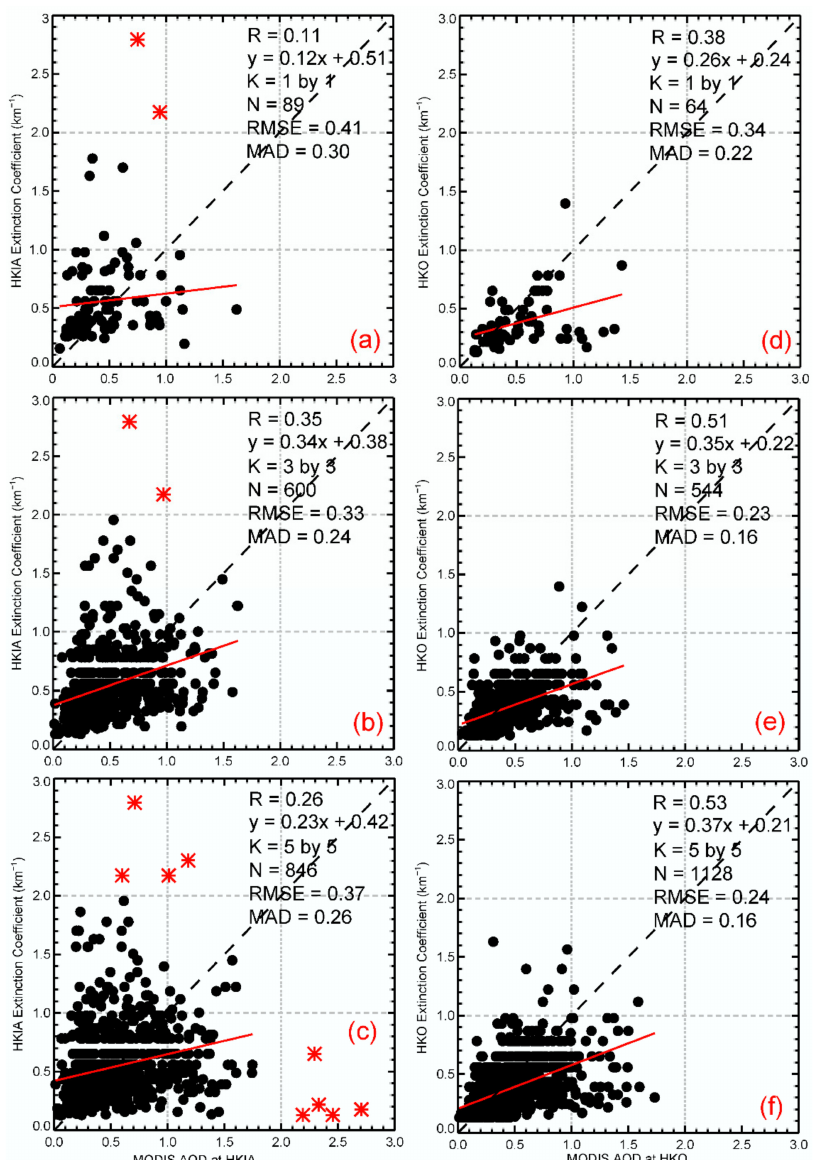
Figure 8. Correlation of Extinction Coefficient with MODIS AOD (10 km product at 550 nm) for HKIA ( a – c ) and HKO ( d – f ) for kernel windows of 1 by 1 (top row), 3 by 3 (middle row) and 5 by 5 (bottom row). *—potential outlier in the data. Lines as described in Figure